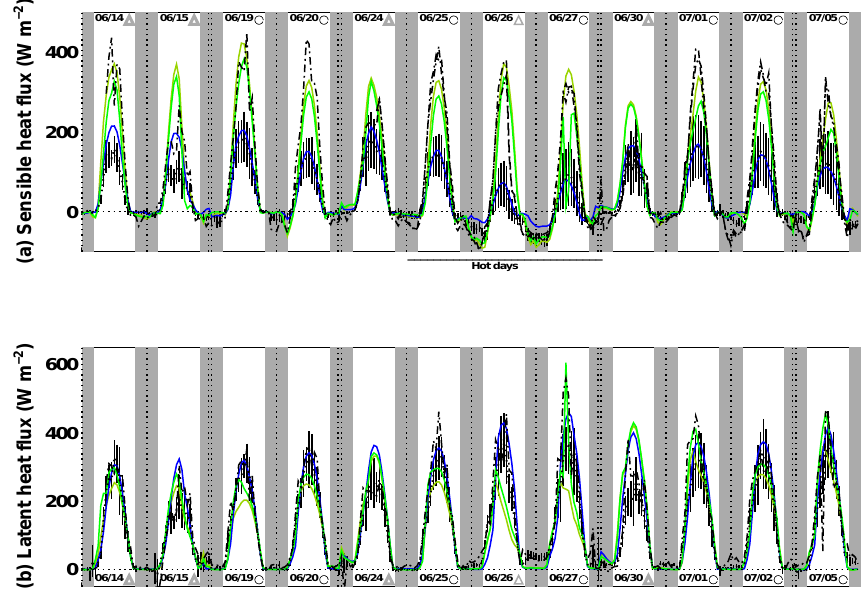
Figure 4. Time series of 24h sequences for the 12 IOPs of (a) sensible heat flux and (b) latent heat flux. Measurements over several surfaces are indicated by a black curve for the mean, with horizontal standard deviations indicated by error bars; the dashed and dot-dashed black lines correspond to the observations over the forest sites that are not included, either in the mean or in the horizontal standard deviations. Values simulated by ARPEGE are indicated in dark blue for point 2, light-green for point 1 and green for point